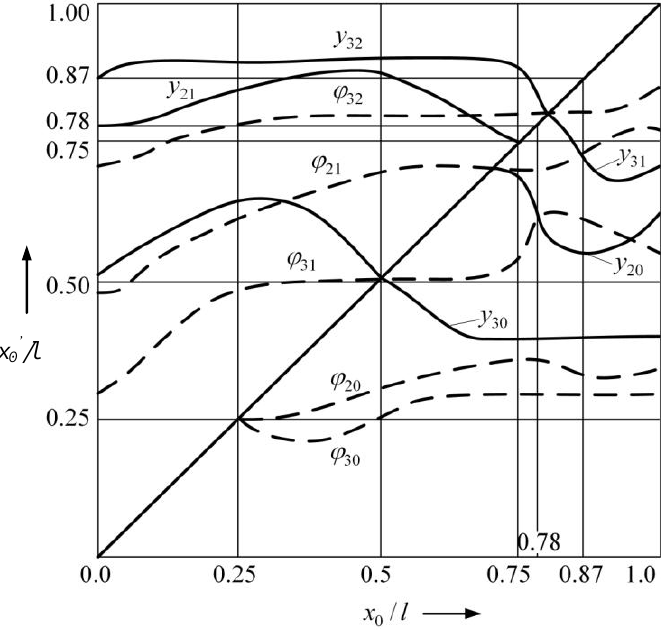
Figure 6. Dependence of nodal points of the displacement ( y modes of the supported cantilever microstructure on the position of the support: i —number of vibration mode, j —sequence number of the nodal point with respect to the anchor point of the